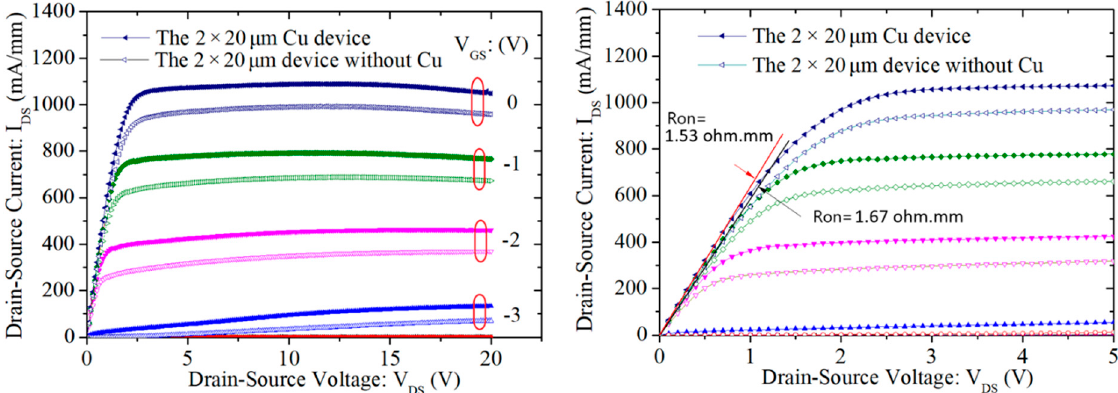
Figure 6. DC characteristic of the 2 × 20 μ m device with thick copper metallization.